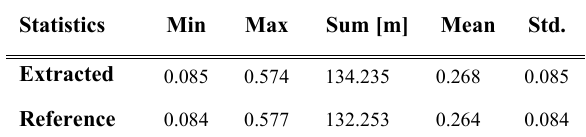
Table 2: Length differences of 500 shells: reference vs.